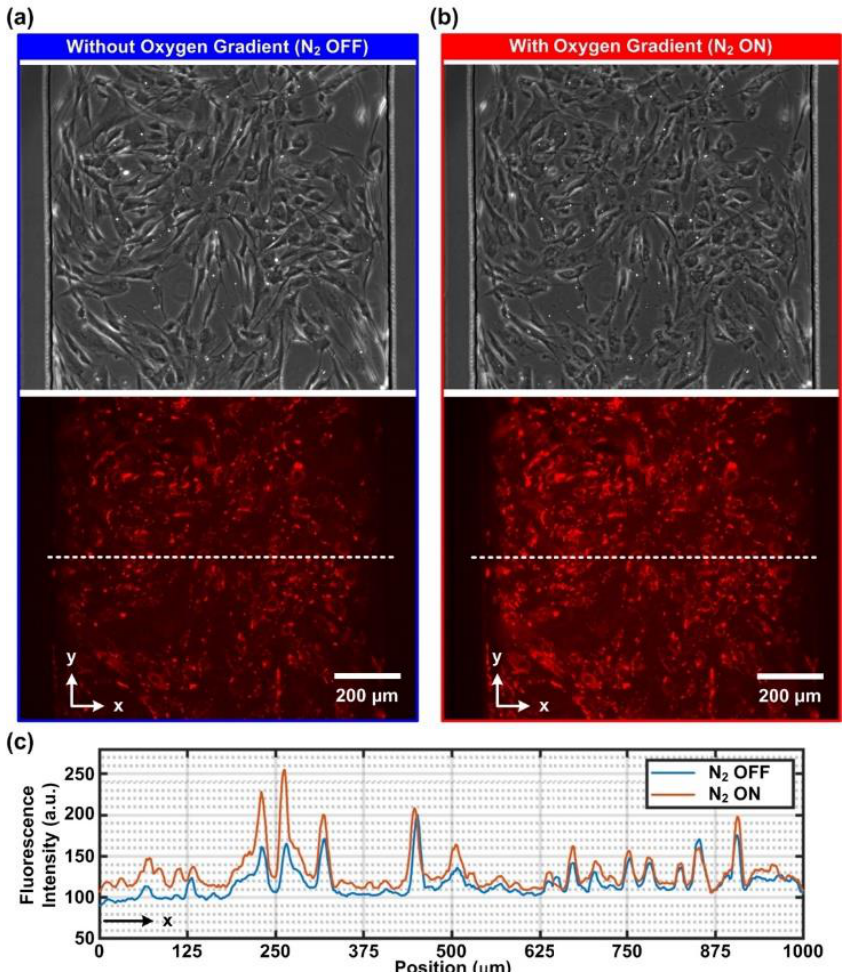
Figure 3. Phase contrast and fluorescence images of AoSMCs treated with the intracellular oxygen- sensitive reagent (MitoXpress Intra) under ( a ) normoxia (N 2 OFF) and ( b ) oxygen gradient (N 2 ON) conditions. ( c ) Representative line profiles of the fluorescence intensity across the width of the channel under the normoxia and oxygen gradient conditions. Compared to the normoxia condition (N 2 OFF), higher fluorescence intensity on the left-hand side under the oxygen gradient condition (N 2 ON) indicates lower intracellular oxygen tension within the AoSMCs.